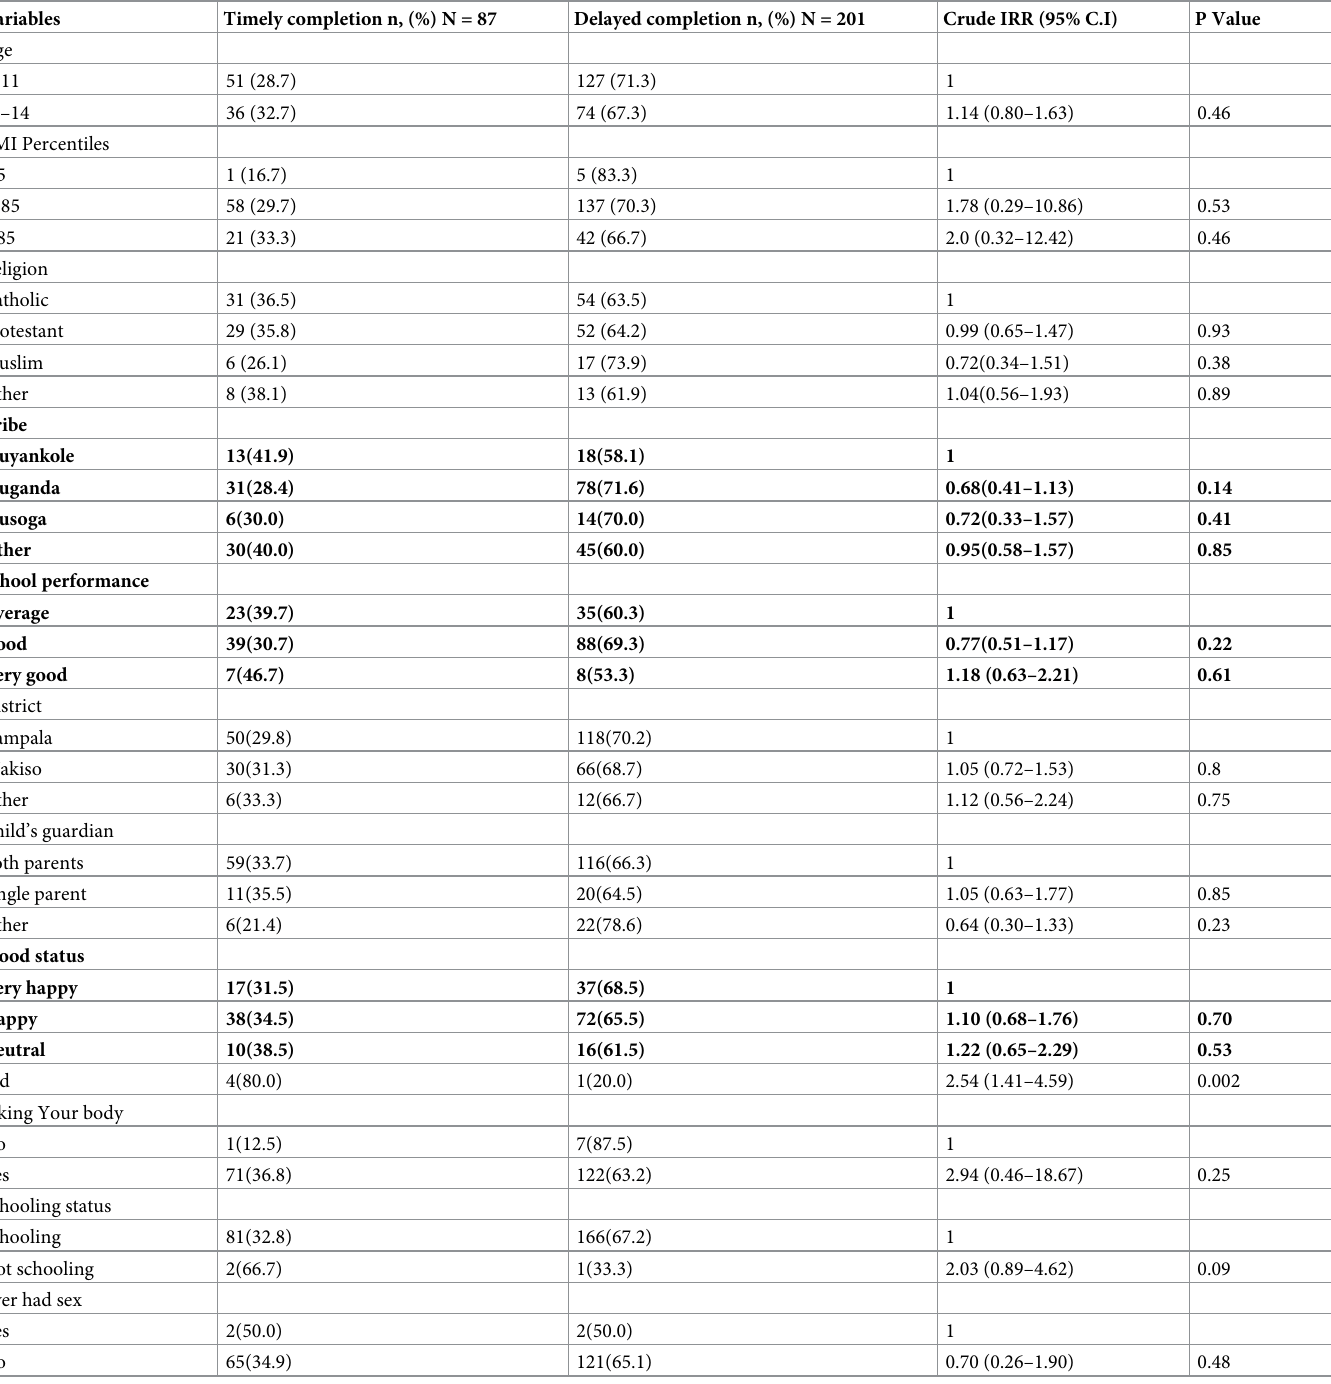
Table 3. Bi-variate analysis of timely completion of HPV vaccination and baseline